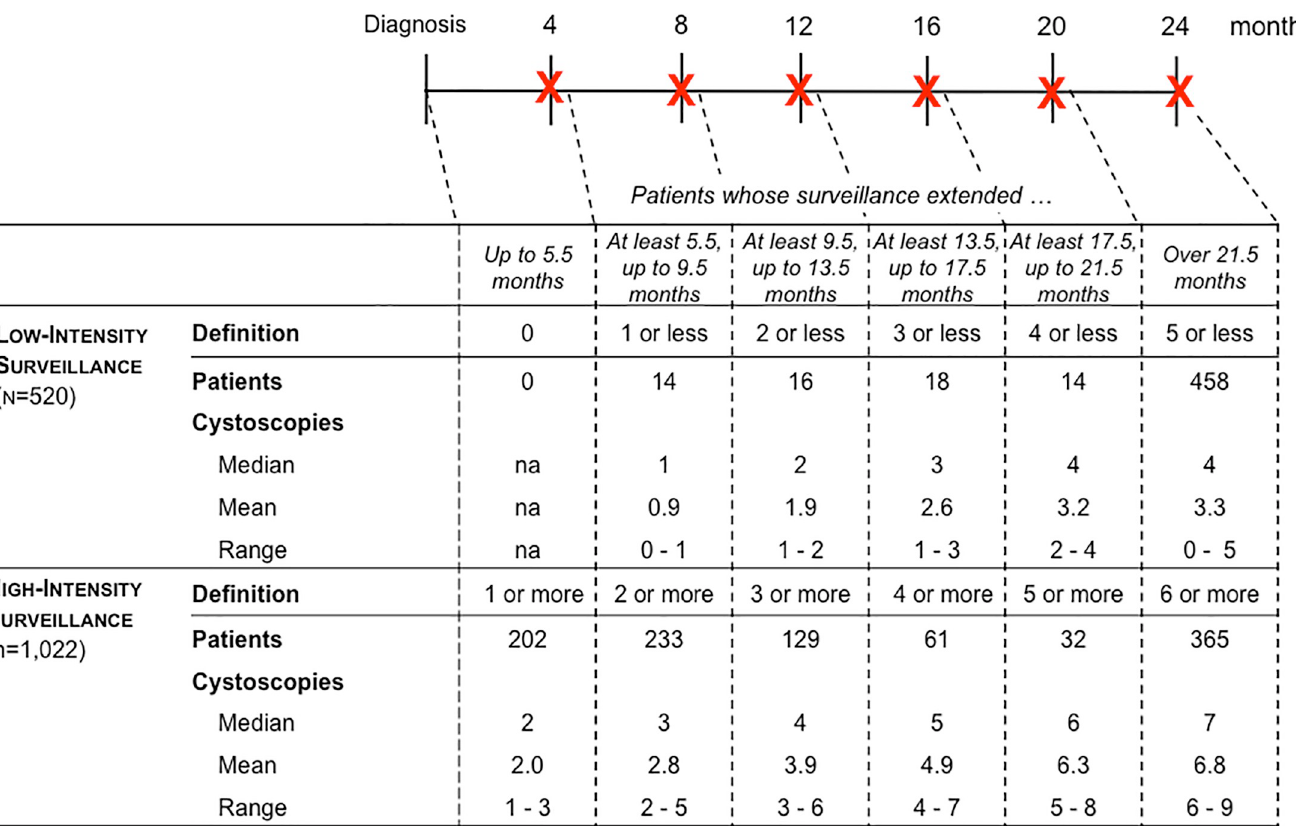
Fig 1. Categorizing patients into low versus high-intensity surveillance based on consensus guideline recommendations and length of the surveillance window. [3] At the top of the figure, the timeline of the surveillance window is depicted in months. X denotes the recommended time of cystoscopy. A 1.5 month grace period was allotted to allow for surveillance cystoscopies that were done slightly later than recommended. For example, a patient followed for 9.5 months (second column) who underwent 0 or 1 cystoscopies was categorized as low-intensity surveillance, whereas a patient followed for 9.5 months who underwent 2 or more cystoscopies was categorized as high-intensity surveillance. In the table, the number of patients categorized into low versus high-intensity surveillance (overall and stratified by length of surveillance window), and number of surveillance cystoscopies is depicted.